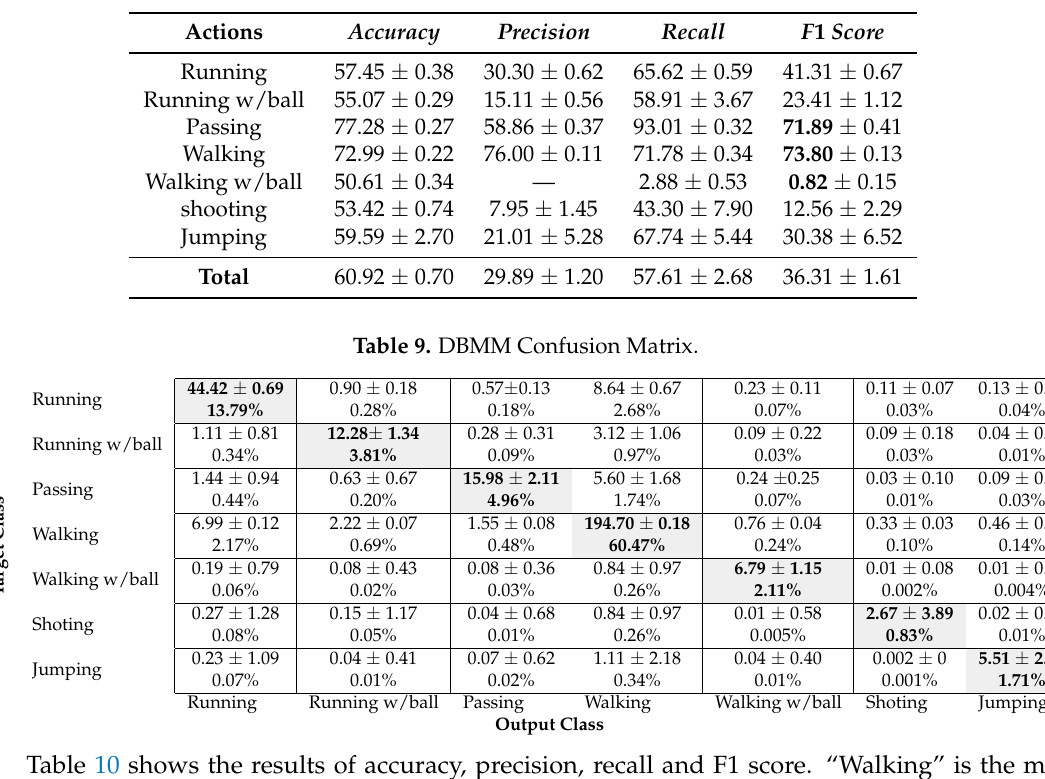
Table 8. LSTM Evaluation Metrics.